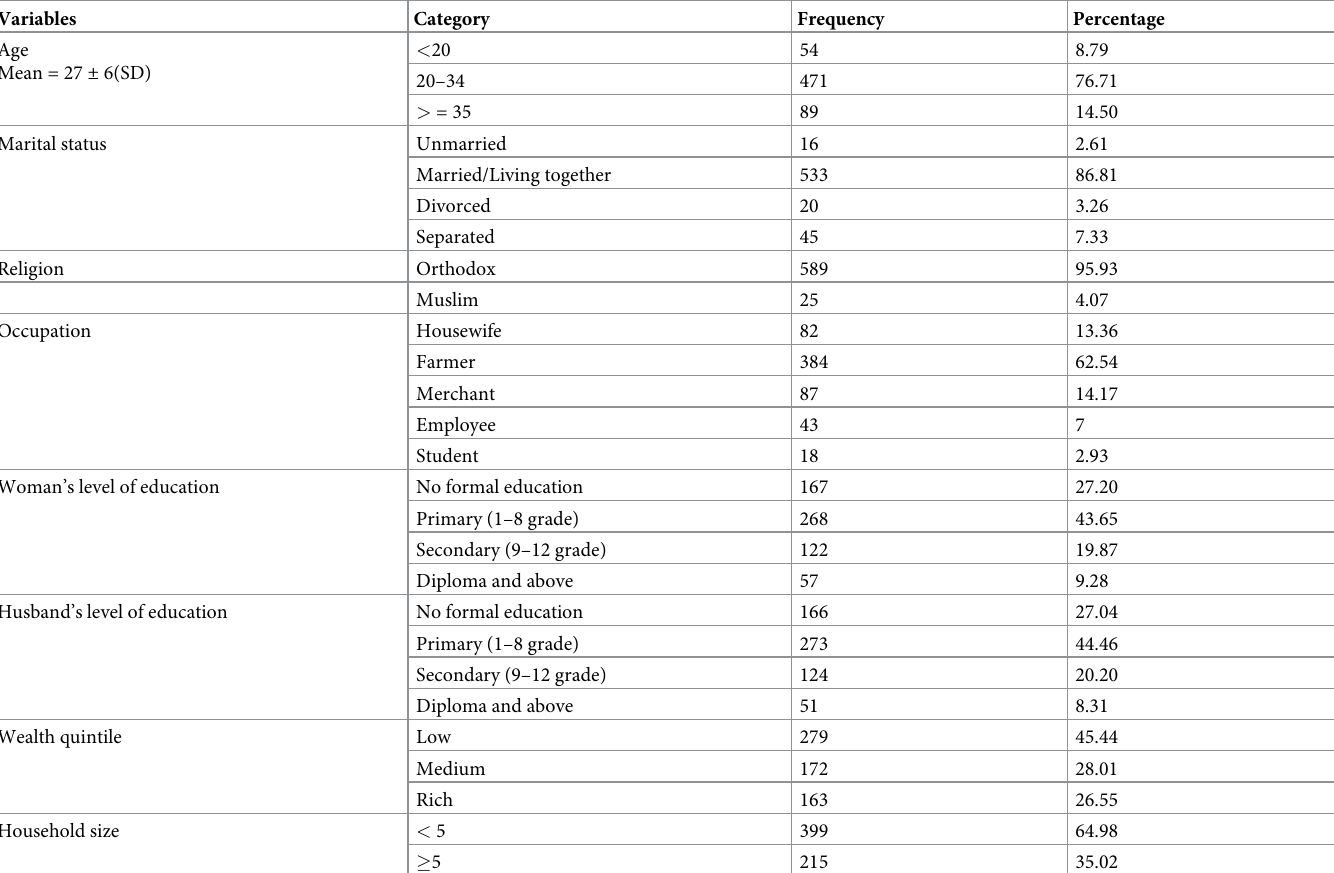
Table 1. Socio-demographic and economic characteristics of pregnant women attending ANC in central zone of Tigray Region, Ethiopia in November 1/2017 to January 30/2018.